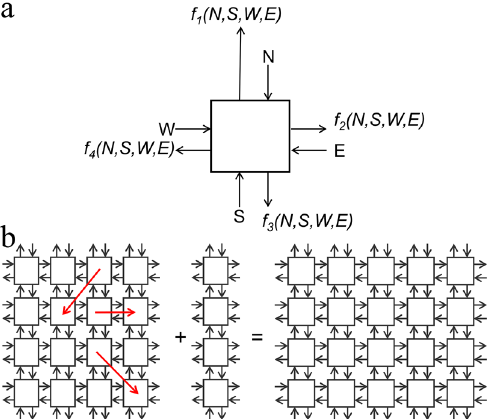
Figure 3. Architecture of a self-configurable and scalable 2D cell matrix. ( a ) Design of a single unit cell with input and output on each side. The cell receives information from neighbor cells, processes it and then feeds its output back to neighboring cells to configure the circuit, ( b ) a cell matrix is perfectly scalable. Adding a 4 ˆ 1 matrix to a 4 ˆ 4 matrix results into a 4 ˆ 5 cell matrix. Red arrows show that each cell can interact with other cells independently and thus provide self-configurability to the